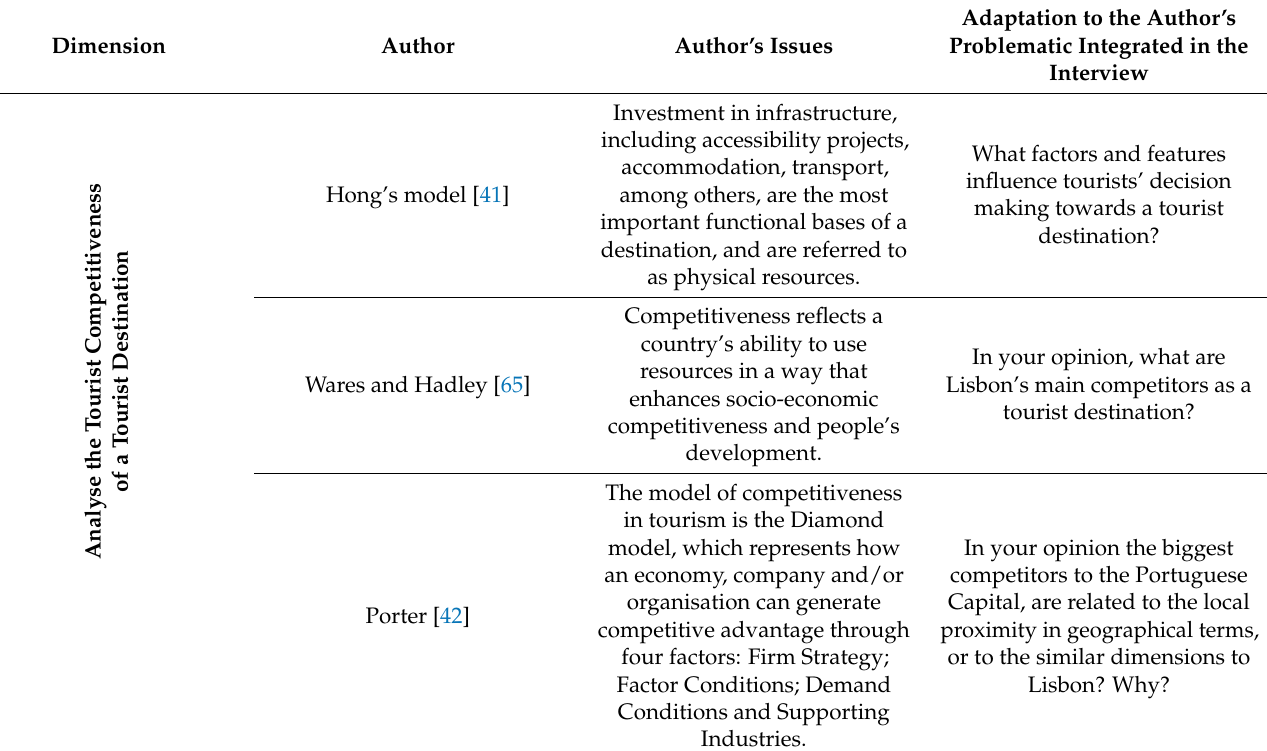
Table 4. Structure of the interview questions considering the ideologies of the authors. Source: Elaborated by the